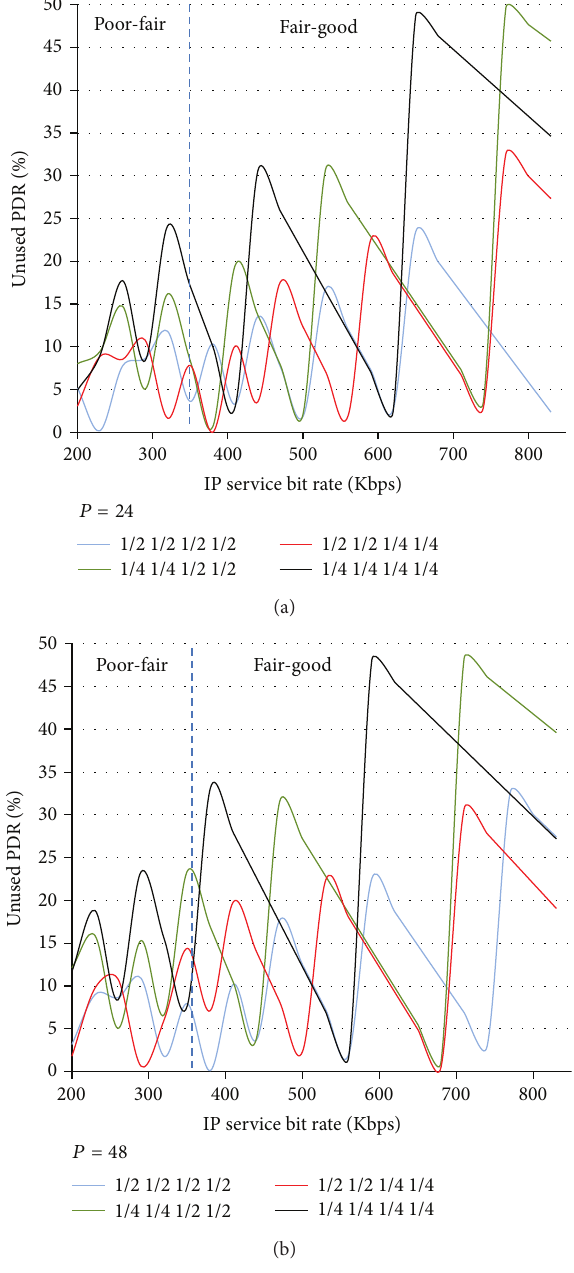
Figure 5: Percentage of payload not used by the MH TV services, in function of the service bit rate and given that the maximum service capacity is attained at this service bit